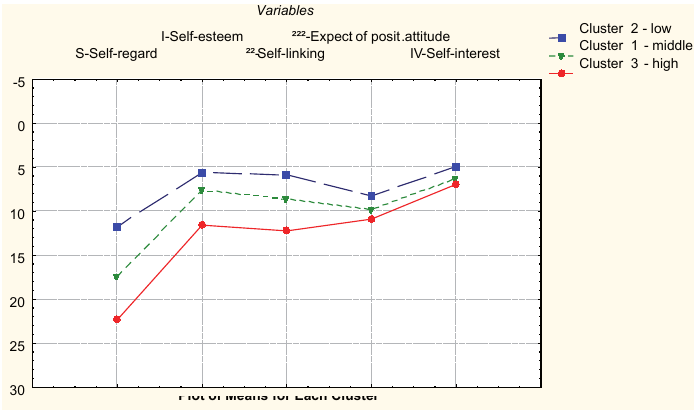
Fig. 4. Clusters singled out according to integral scales of